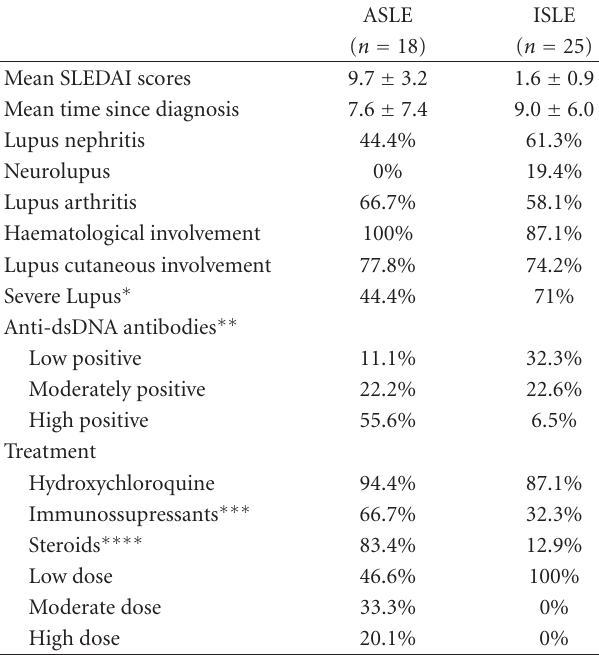
Table 1: Clinical findings in 43 patients with systemic lupus erythematosus